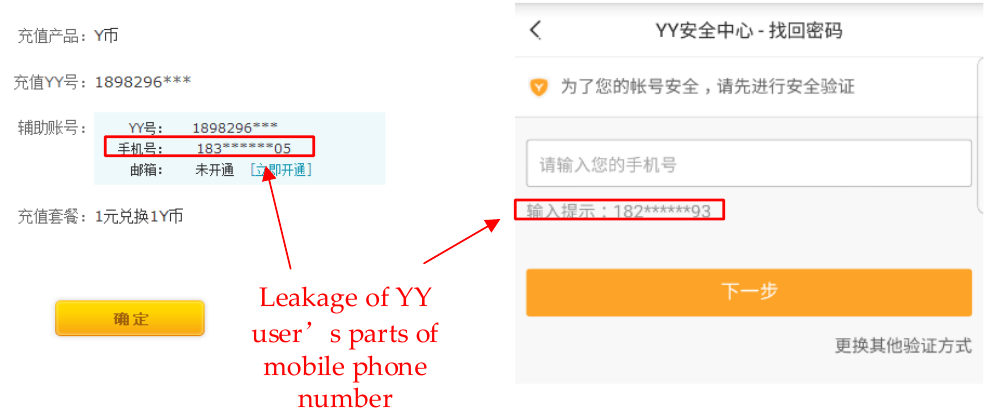
Figure 7. User interfaces of leakage of parts of a user’s mobile phone number.